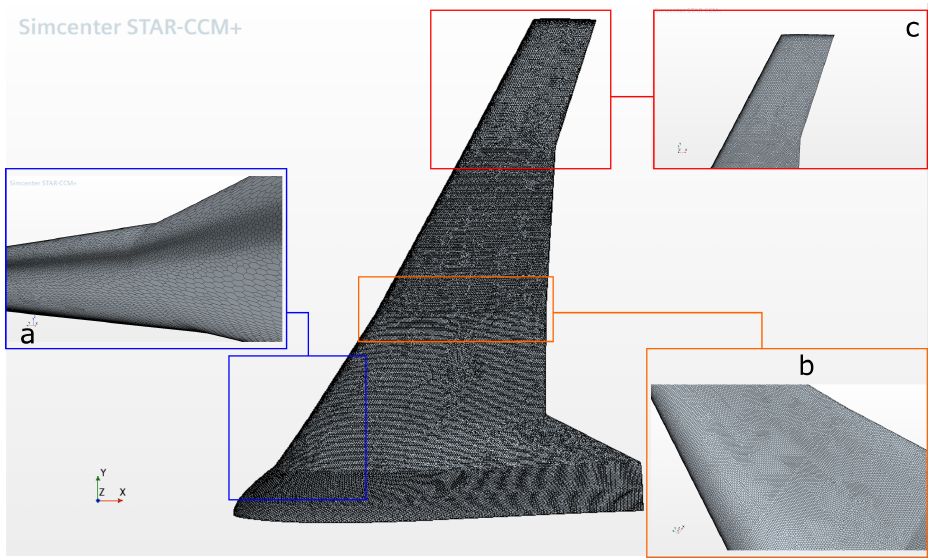
Figure 6. Surface Mesh. Table 8. Domain Evaluation for Spalart–Allmaras Turbulence